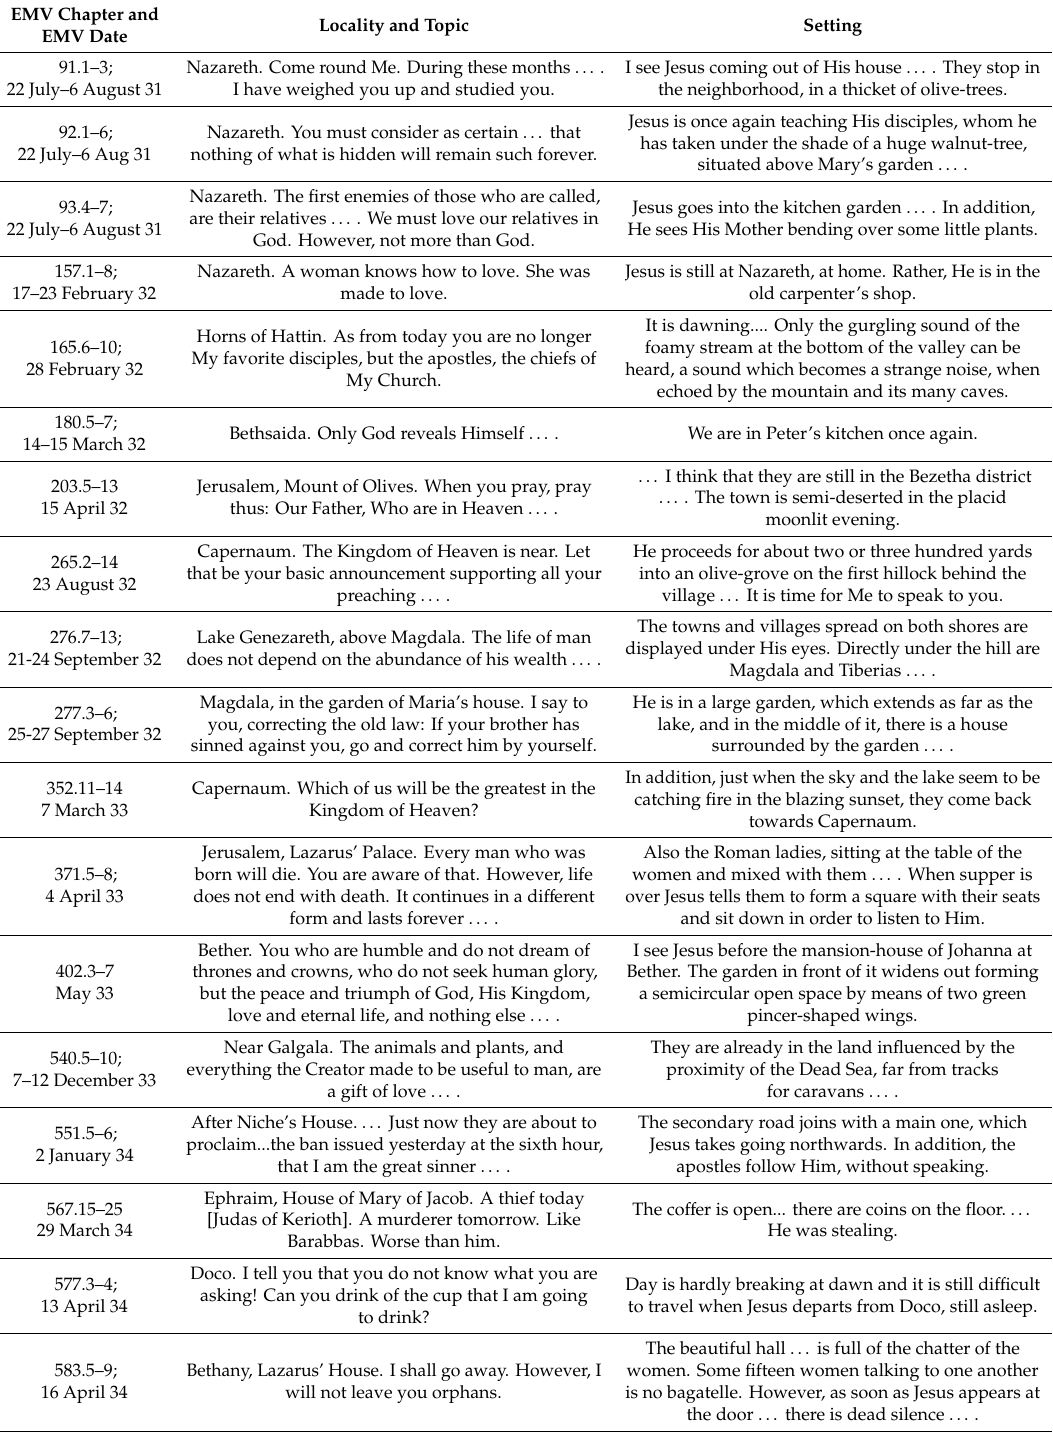
Table A3. Date, locality, a brief mention of the topic and setting of the speeches delivered to disciples (21